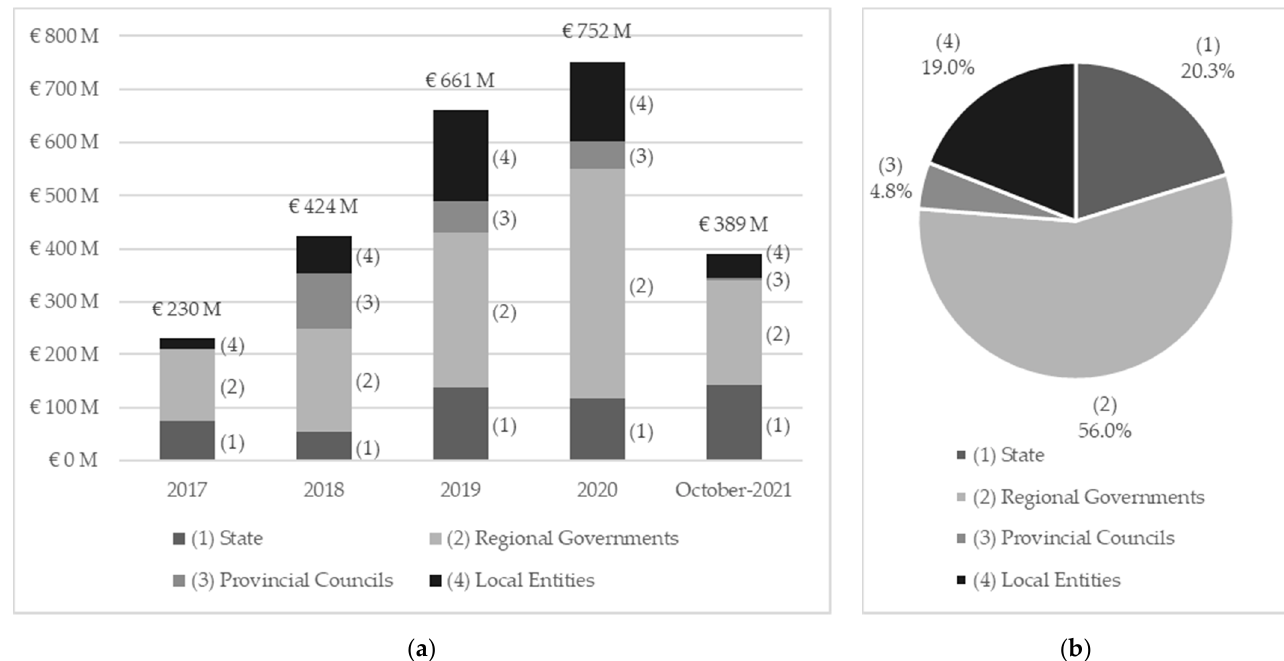
Figure 4. Evolution of tenders in Spain 2017–2021: ( a ) Annual investment volumes for the period; ( b ) Distribution of tenders by level of administration. Source: Own elaboration based on [33].